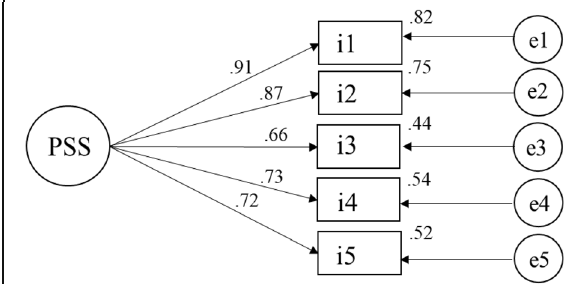
Fig. 2 Confirmatory factor analysis of one-factor model of the PSS among Brazilian international